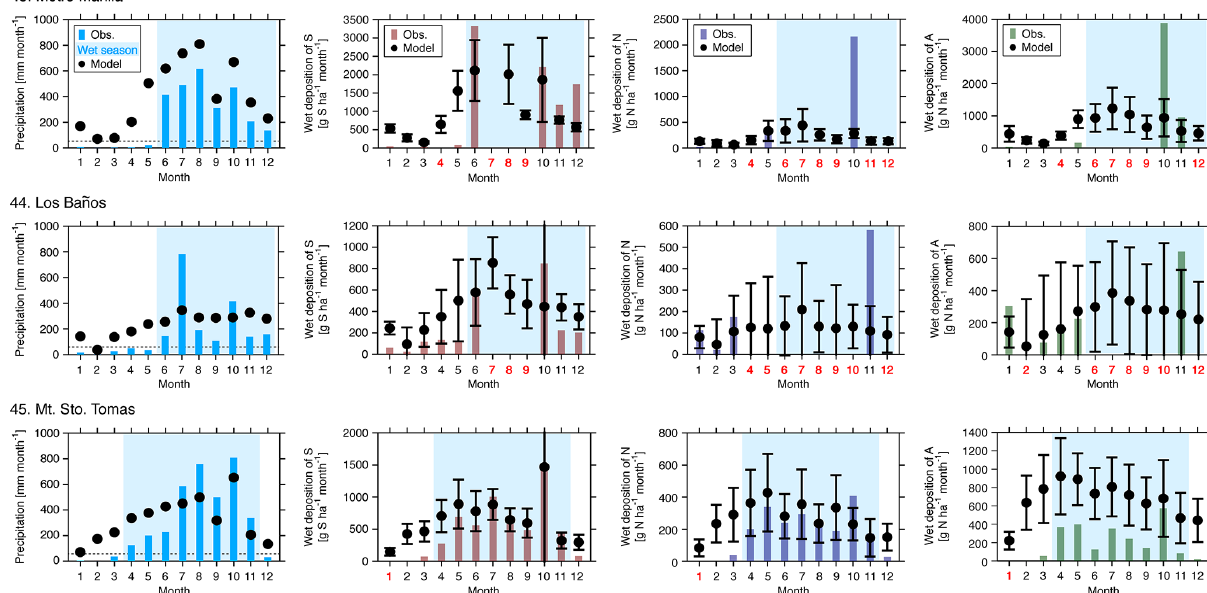
Figure 6. Monthly accumulated precipitation and wet depositions of S, N, and A over the Philippines. Whiskers represent the standard deviation among the seven models, and the wet season (light blue color) is defined as months when precipitation exceeded 50mm. Months shown in red indicate a lack of observational data. Table 7. Statistical analysis of the model performance for three sites in the Philippines. Wet deposition of